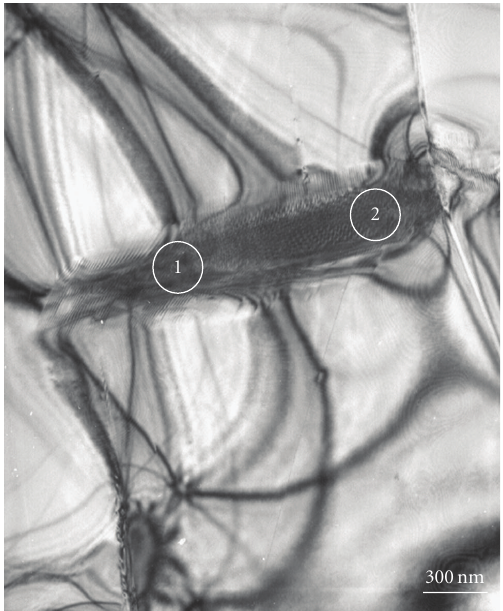
Figure 6: Bright field image of a plate-like precipitate with locations 1 and 2 used for recording SAD